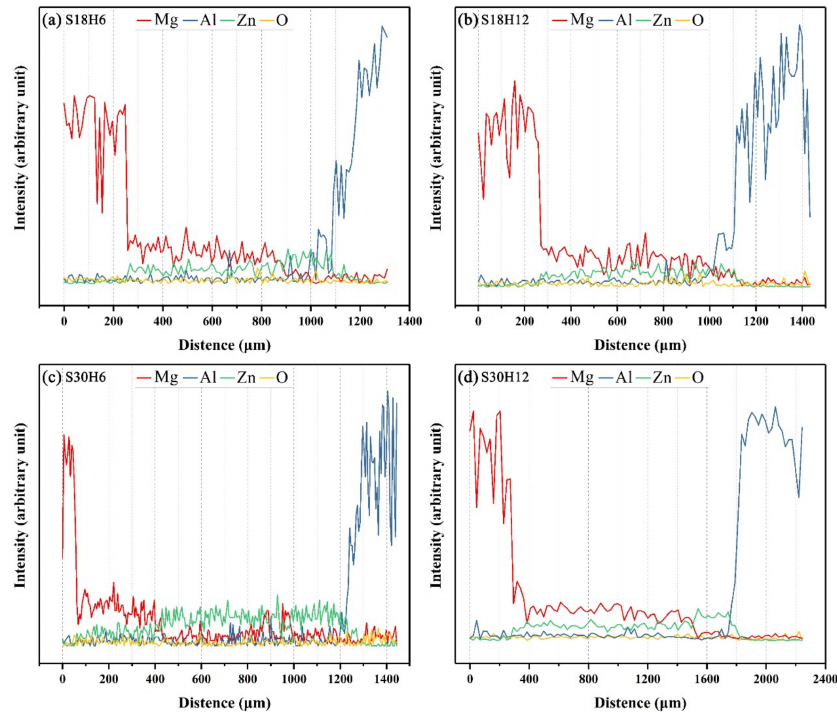
Figure 9. EDS line scan spectra across the interfaces of arc-sprayed Al / AZ91D with a Zn interlayer: ( a ) S18H6, ( b ) S18H12, ( c ) S30H6 and ( d ) S30H12, as marked by dashed lines in Figure 5a, Figure 6a, Figure 7a, and Figure 8a, respectively.